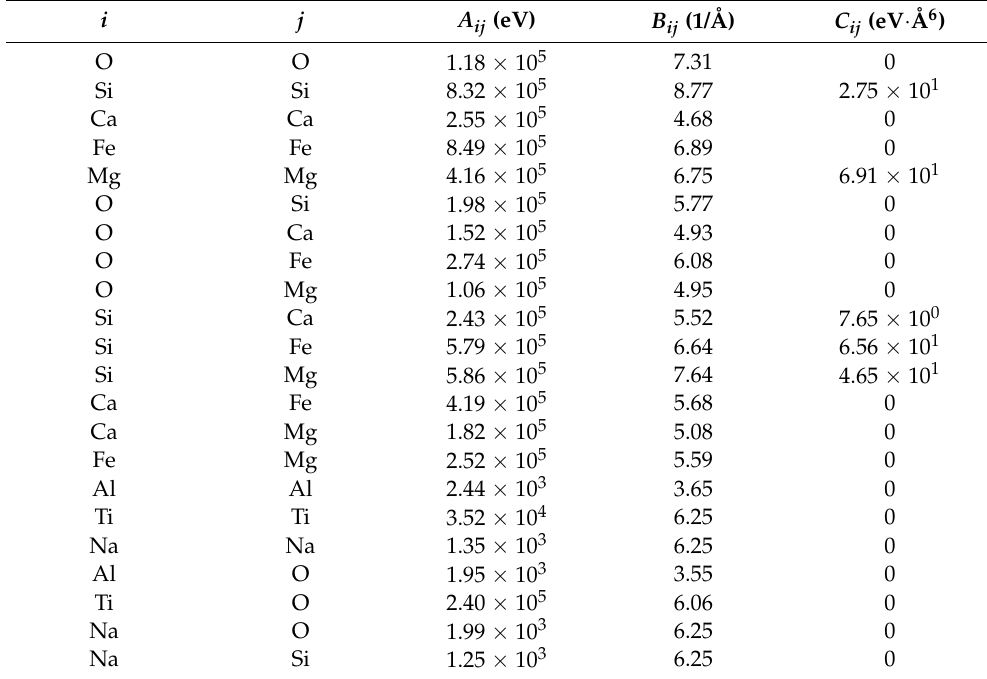
Table 1. Potential parameters in this study.